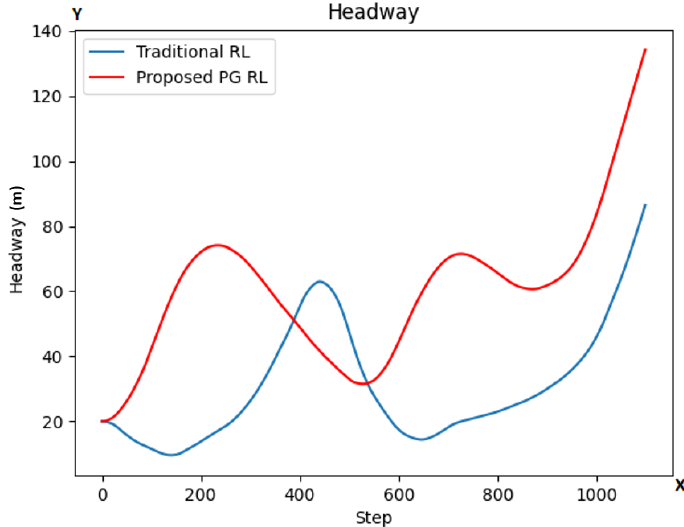
Figure 6. HW values at each step for both models (traditional RL in blue color line; our proposed PG RL model in red color line). The y -axis is representing the HW values while the x -axis represents the number of simulation